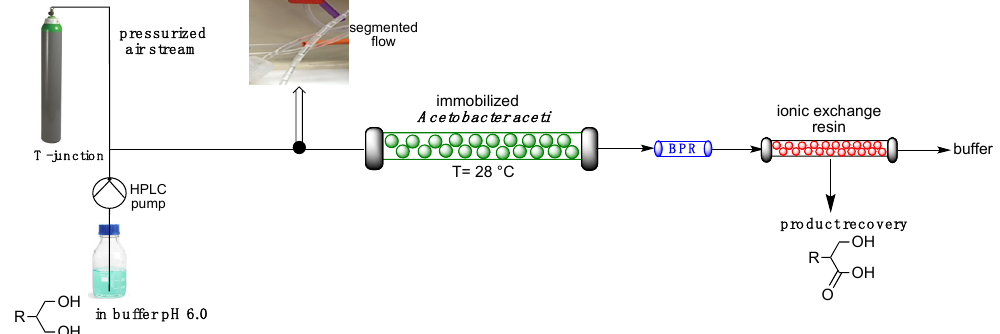
Scheme 2. Outline of the flow reactor and recovery